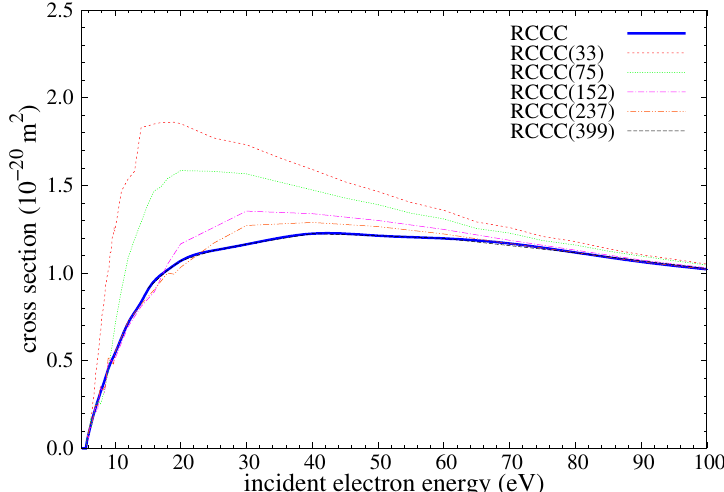
Figure 15. Convergence of the RCCC-integrated cross section for the dipole-allowed transition 5 p 2 3 P 5 p 5 d 3 D ○ 1 . 0 (cid:1)